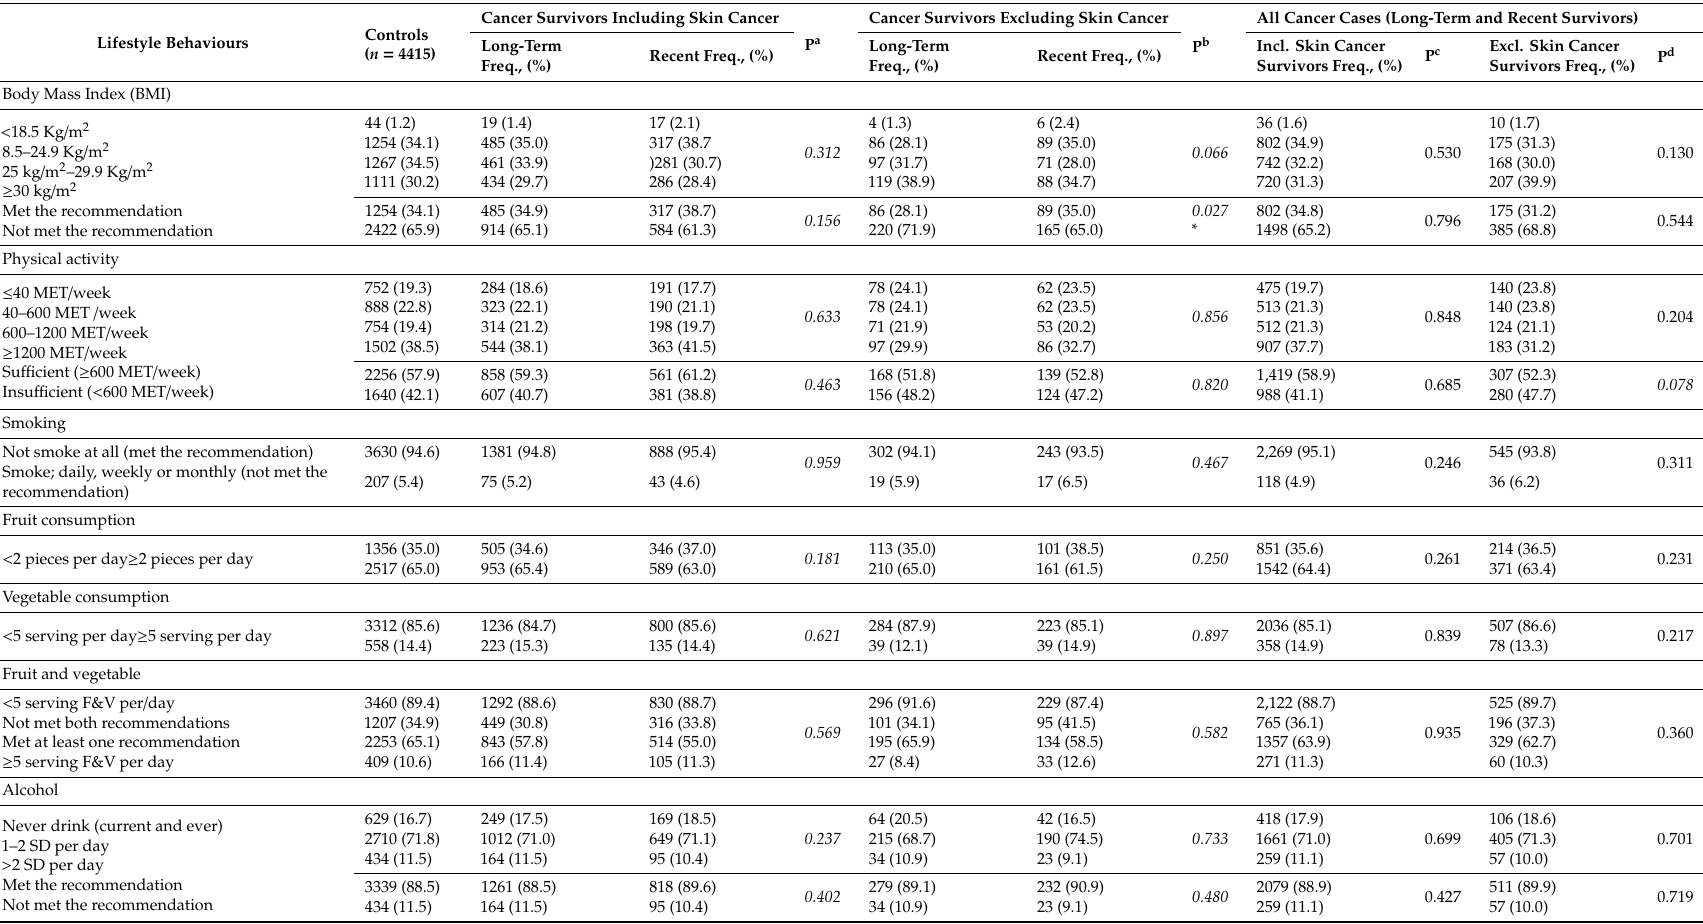
Table 3. Descriptive statistics on adherence to individual and multiple lifestyle behaviours among cancer survivors (with and without skin cancer), compared with